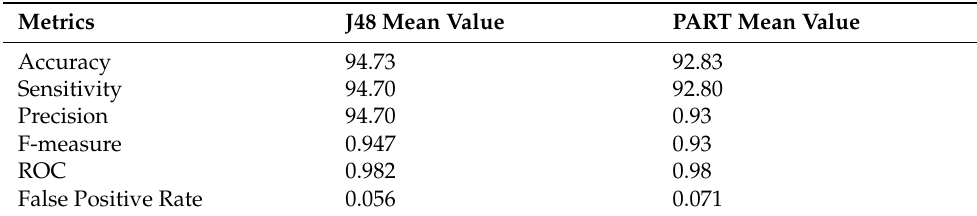
Table 4. J48 and PART algorithms binary classification